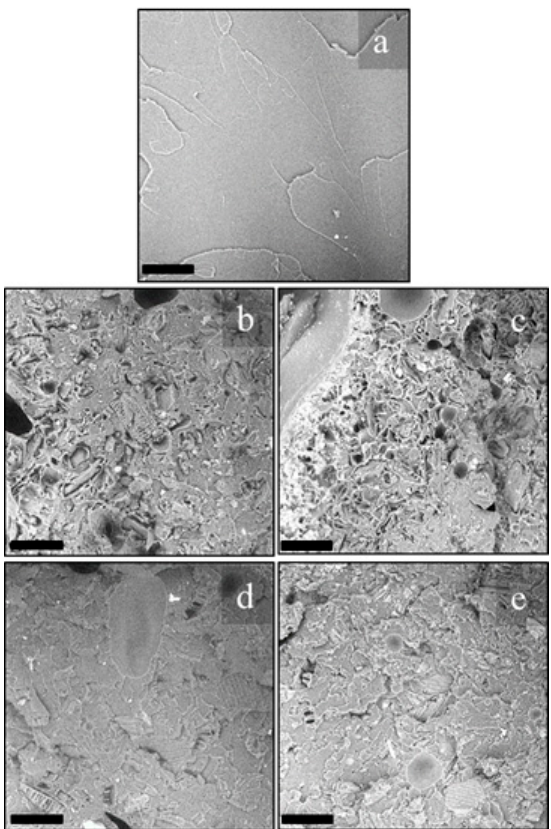
Figure 8. SEM micrographs of cryofractured cross-sections of PLA ( a ), OFI10 ( b ), OFI20 ( c ), POL10 ( d ) and POL20 ( e ) extruded filaments; scale bar 100 μ m.